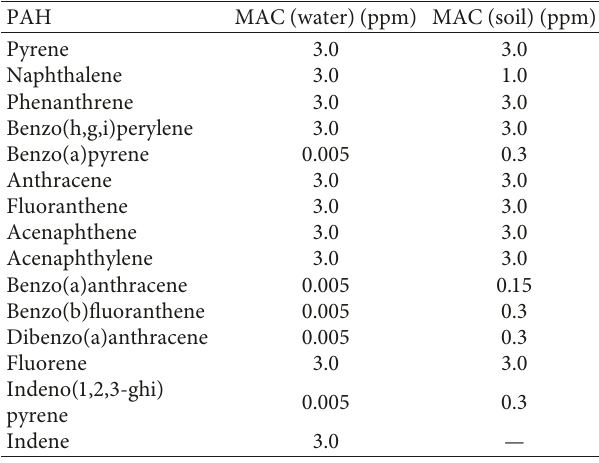
Table 2: Toxicity equivalent factors (TEFs) of PAHs [11]. Table 3: Maximum allowable concentrations (MACs) of PAHs in water and soil